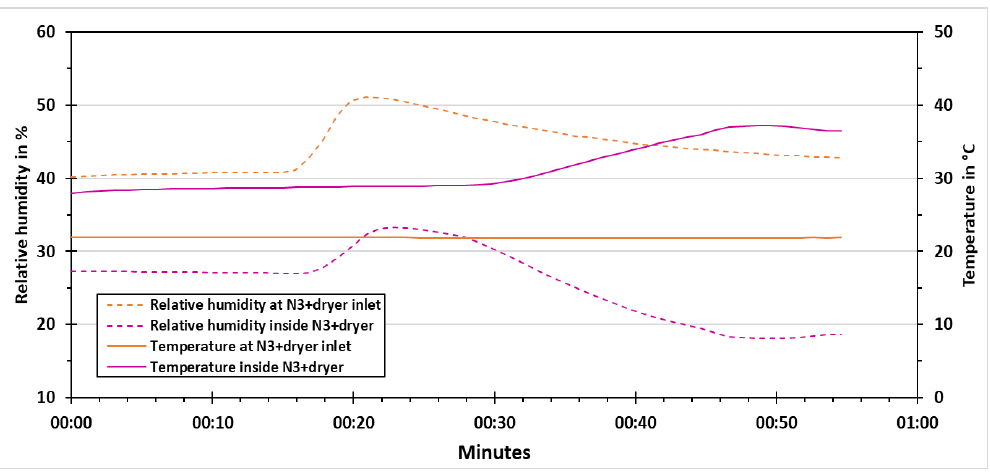
Figure 13. Temperature and relative humidity results for N3+dryer at an applied voltage of 8 V.